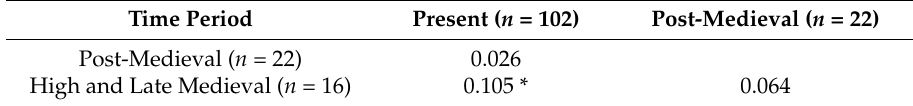
Table 2. Pairwise Φ ST values for the concatenated hypervariable part of the mitochondrial DNA (mtDNA) control region (204 bp) of the domestic goose between the Present Period, the Post-Medieval Period (16th–18th centuries) and the High and Late Medieval Periods (11th–15th centuries). Statistically significant values ( p < 0.05) after Bonferroni correction indicated with an asterisk. Time Period Present ( n = 102) Post-Medieval ( n = 22) Post-Medieval ( n = 22) 0.026 High and Late Medieval ( n = 16) 0.105 *